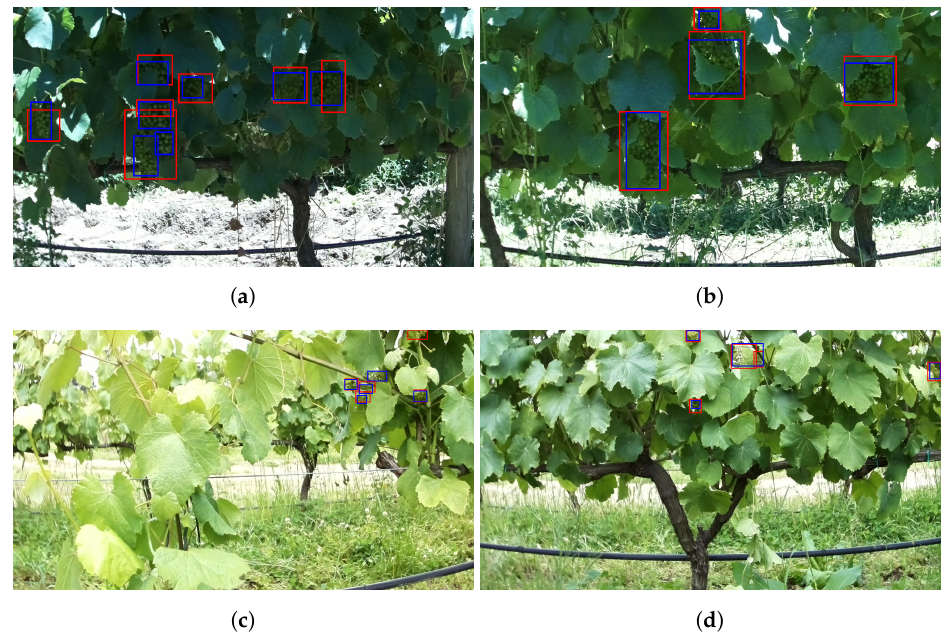
Figure 11. Demonstration of the differences in illumination captured by the proposed dataset and the corresponding ability of the models to deal with it. Each image ( a – d ) represents a different light condition. Blue bounding boxes represent the ground truth and the red ones the